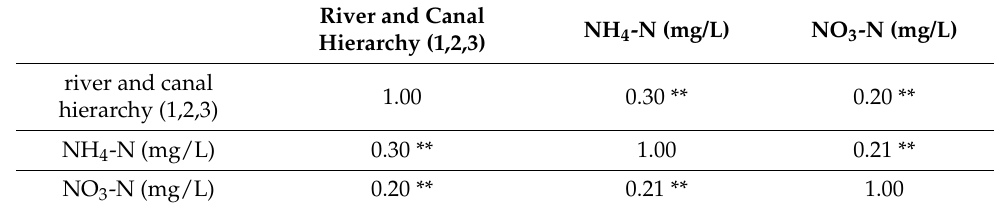
Table 3. Correlation coefficients of river and canal hierarchy and nitrogen content. River and Canal Hierarchy (1,2,3)